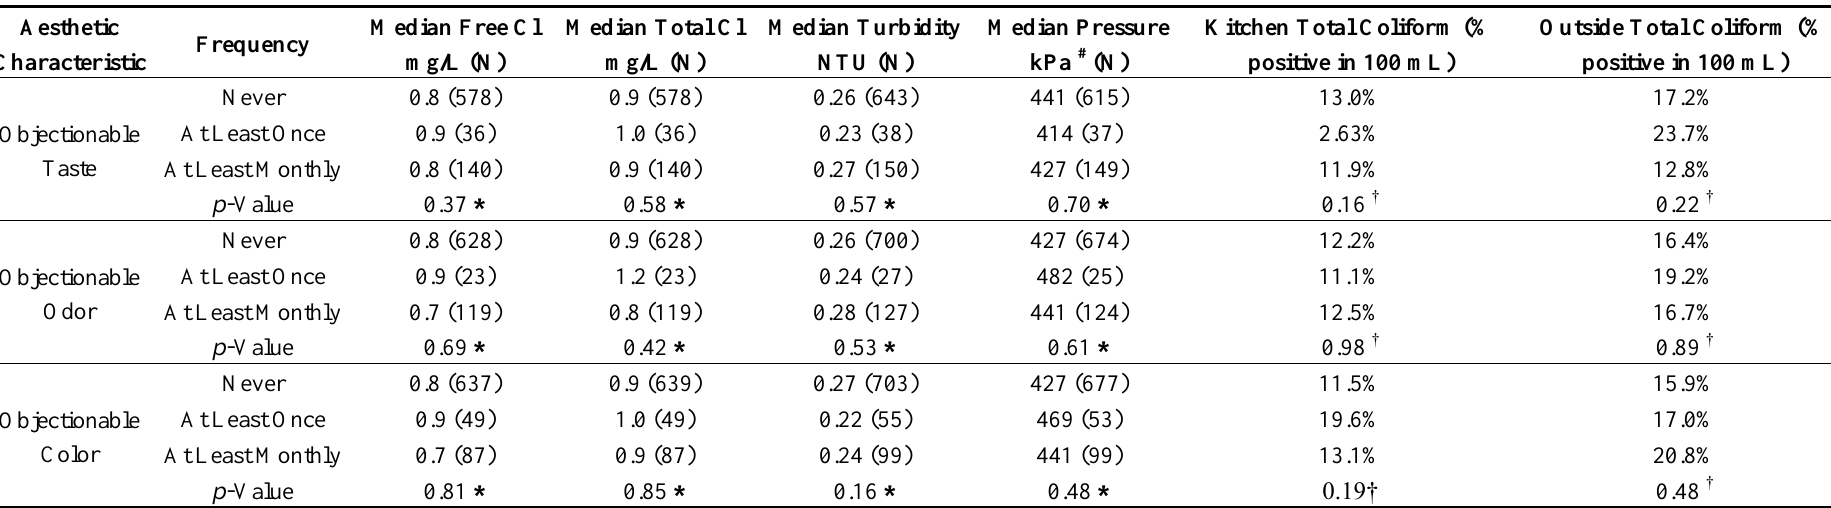
Table 4. Association between reported taste, odor and color issues and measured water quality in a sample of households of three rural counties in Alabama